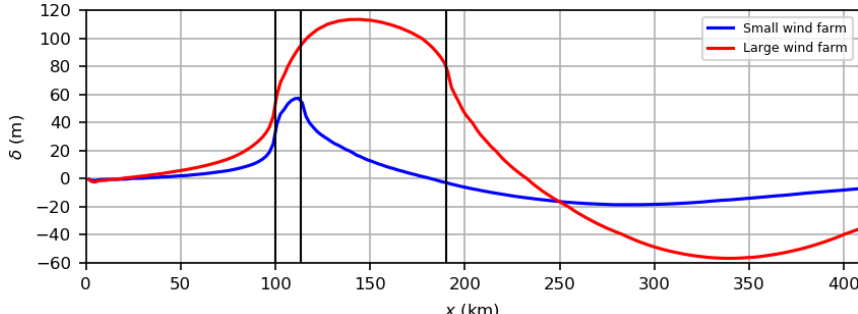
Figure 7. Inversion layer displacement δ . Vertical black lines indicate LE and TE of the small and large wind farm.